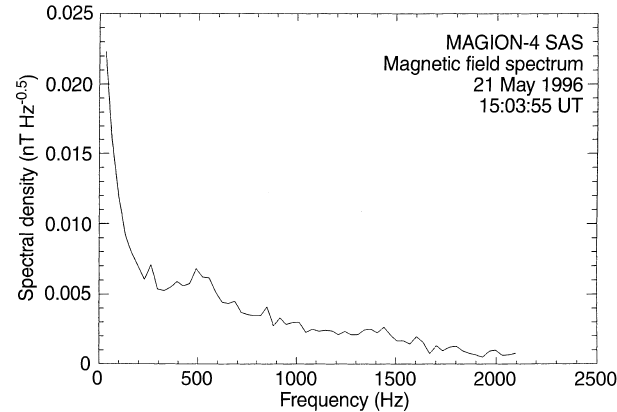
Fig. 5 . The spectrum of the magnetic-field ( B x -component) fluctua- tions taken during the